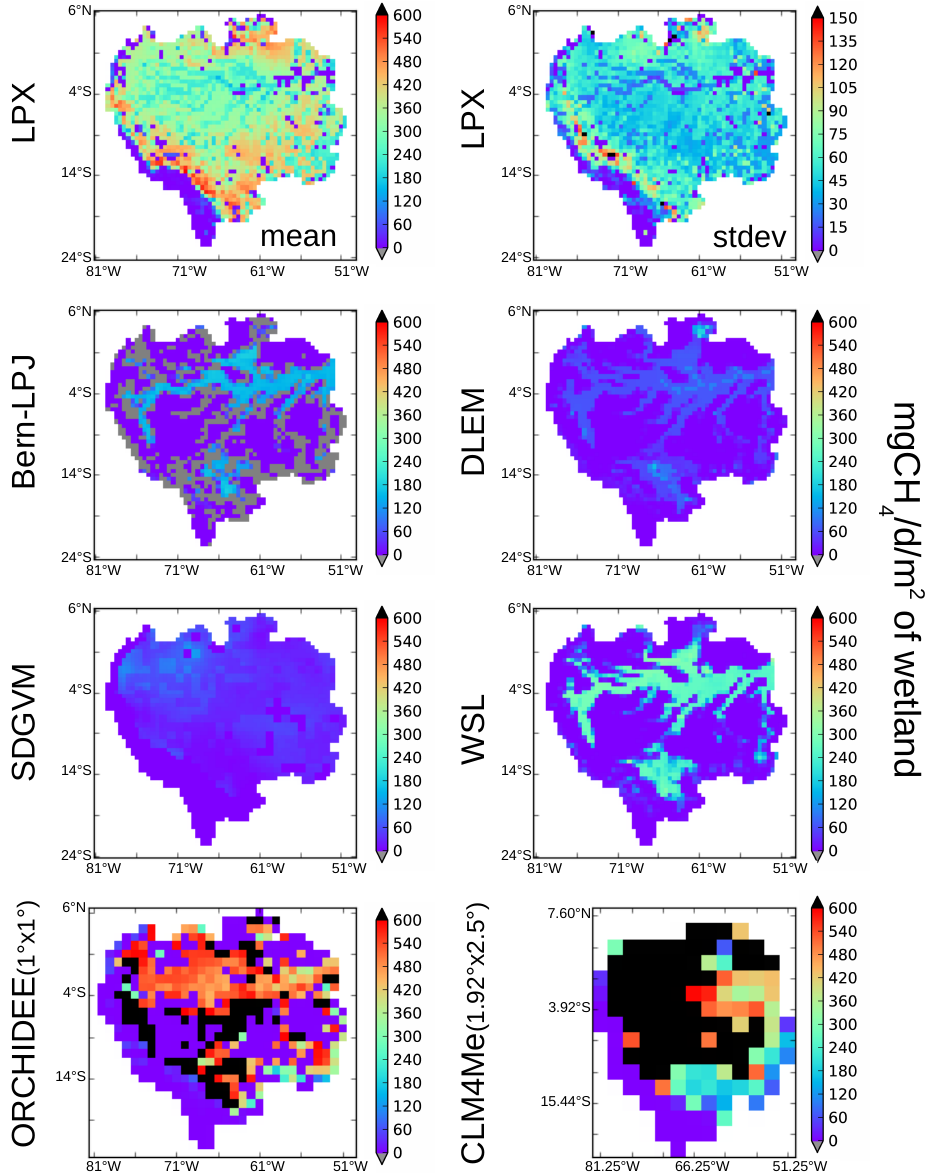
Fig. 8. CH 4 flux densities (mgCH 4 d − 1 m − 2 of wetland) for LPX (top line; left: mean between the seven simulations of the Table 4; right: std between the same seven simulations) and six models participating in WETCHIMP. Note that both ORCHIDEE and CLM4Me have a resolution different from 0.5 ◦ lat × 0.5 ◦ lon (respectively 1 ◦ × 1 ◦ and 1.9 × 2.5 ◦